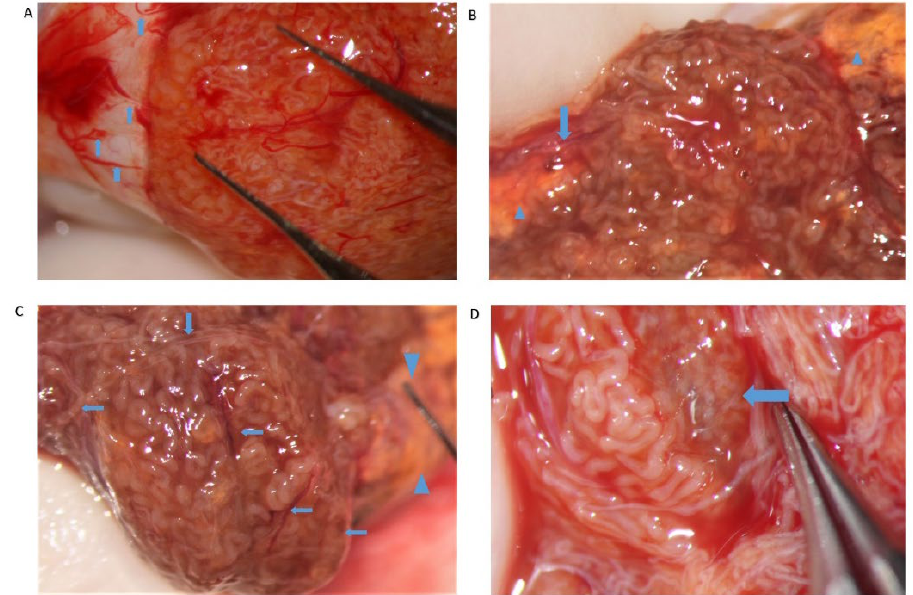
Figure 7. ( A ) Dilated tubules are found close to sub-albugineal vessels (arrows); ( B ) a lobule of dilated tubules supplied by a vessel (arrow), amidst two yellow areas full of Leydig cells (wedges); ( C ) an entire lobule of tubules with different calibers, but mainly dilated, well nourished by many vessels (arrows); in the background, out of focus, yellow tissue full of Leydig cells (between wedges); ( D ) a medium-sized group of dilated tubules close to blood vessels and a brown-yellowish Leydigian area (arrow).